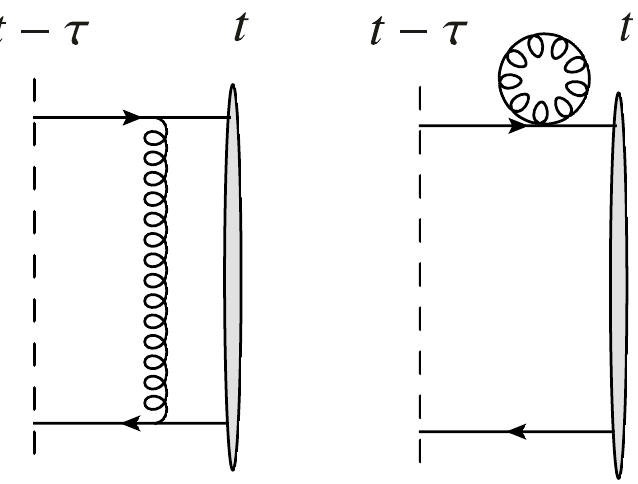
Figure 4 . These diagrams illustrate generic processes taken into account in eq. (2.26), in the case of the single particle density matrix. Note that there is another diagram with a tadpole insertion, on the lower line, not drawn. Depending on the operator considered, the propagator of the gluon corresponds to V , W or involves spatial derivatives of W . Note that since we treat the heavy quarks and antiquarks as non relativistic particles, the direction of the arrows in such a diagram does not refer to the nature (quark or antiquark) of the heavy particle: rather, it is correlated to the SK contour time, forward (to the right) in the upper branch, backward (to the left) in the lower